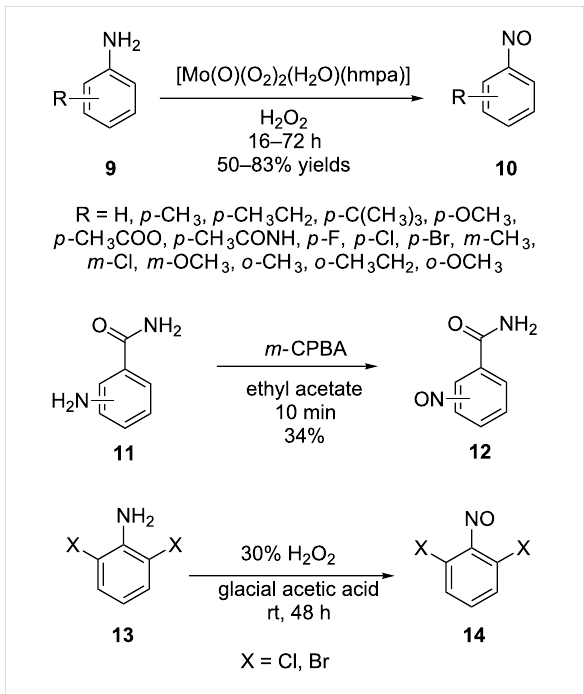
Scheme 4: Synthesis of arylnitroso compounds by amine